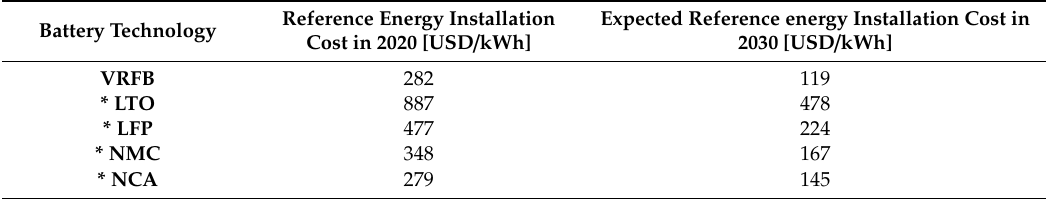
Table 1. Energy installation cost reference values of Li-ion and vanadium redox flow battery (VRFB) batteries for 2020 and 2030 based on [42]. Battery